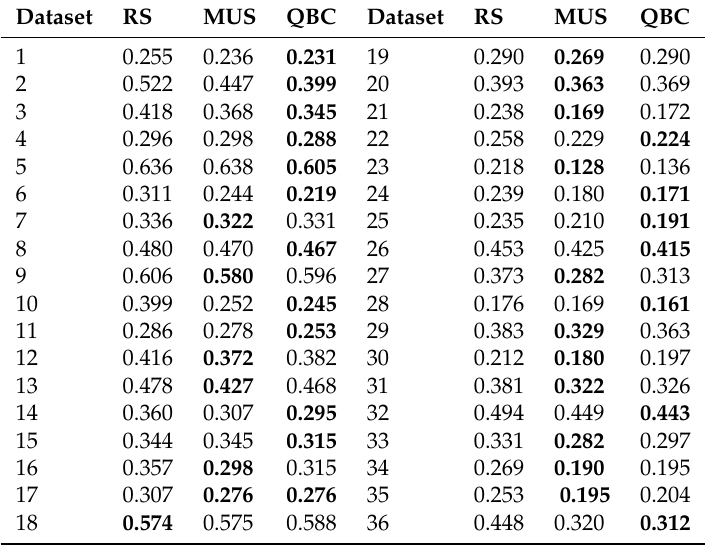
Table 4. Values of the average of E obtained in the 10th iteration of the algorithm for all strategies. The smallest value of E within query strategies is in